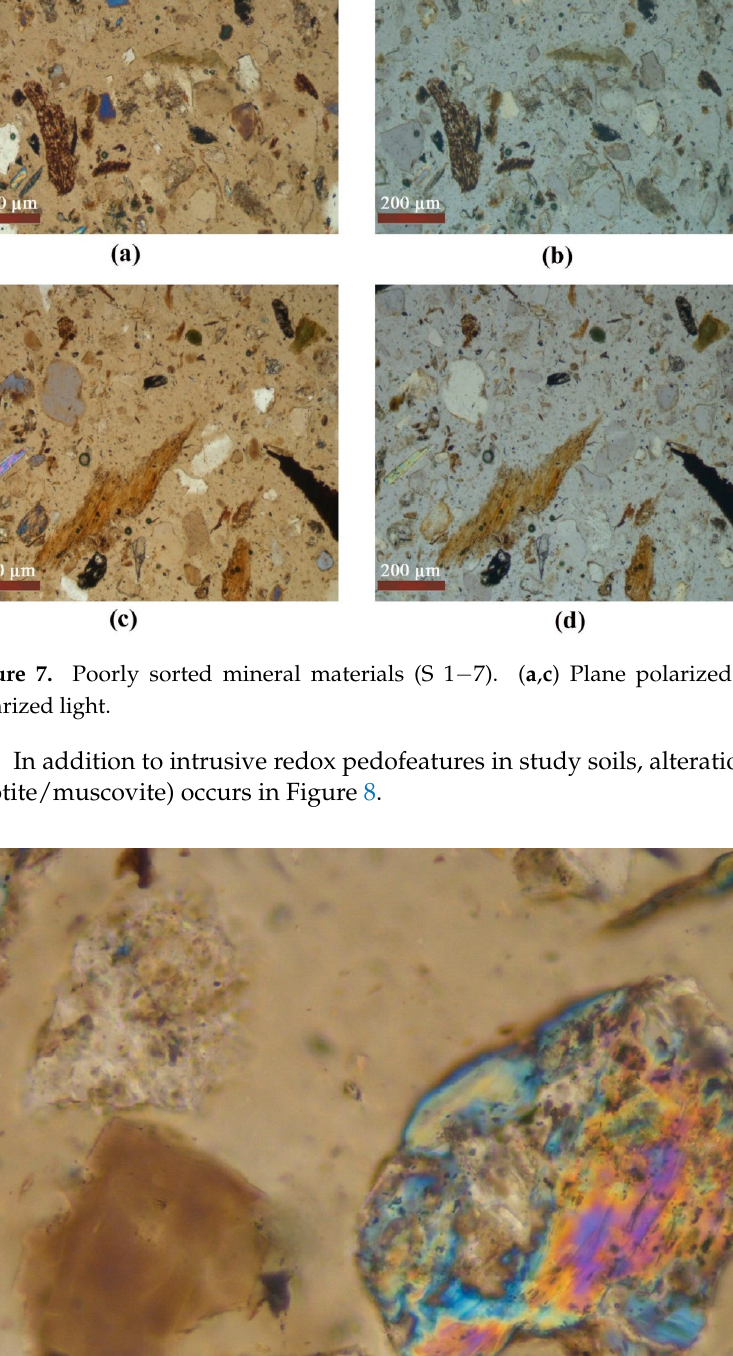
Figure 8. Muscovite, third terraces of Samoylov Island. (S 1 − 6). Plane polarized light.